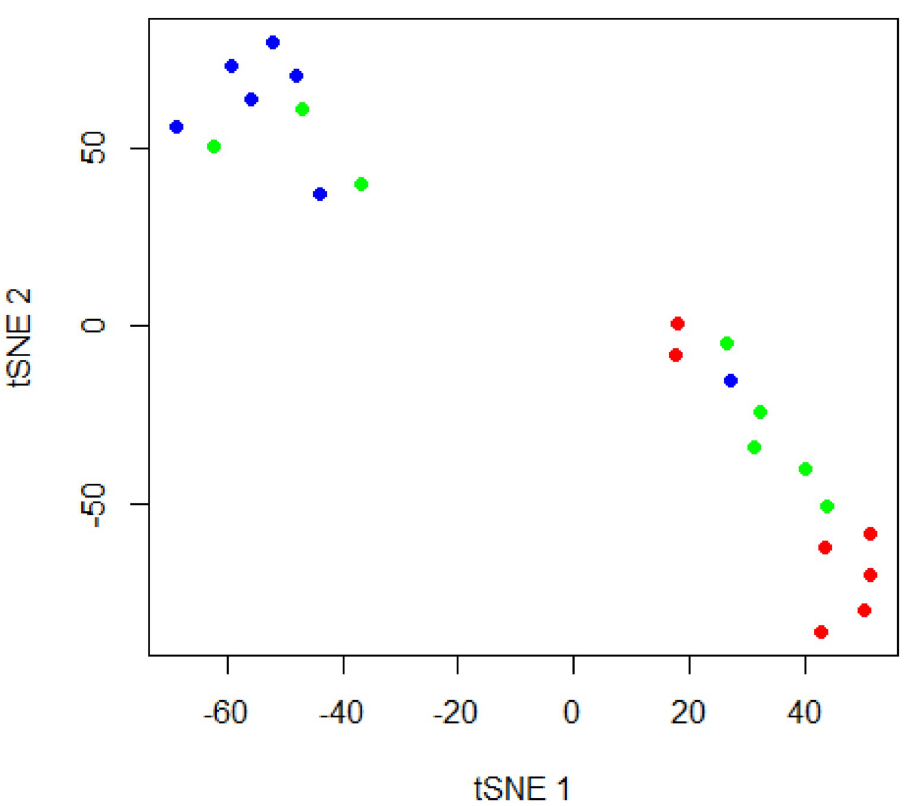
Fig 4. T-distributed stochastic neighbor embedding (tSNE) plot of cytokine profiles from bronchoalveolar lavage samples. Culture-negative (C-) samples are shaded in blue, culture-positive (C+) in red, and respiratory tract flora (RTF) samples in